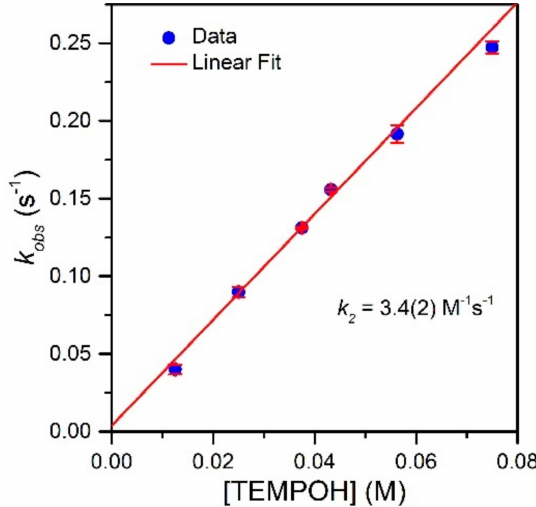
Figure 6. Pseudo-first-order rate constants k obs (s − 1 ) as a function of TEMPOH concentration for a 1.25 mM solution of [Mn III (OH)( 6Me dpaq)](OTf) in MeCN at − 35 ◦ C. The second-order rate